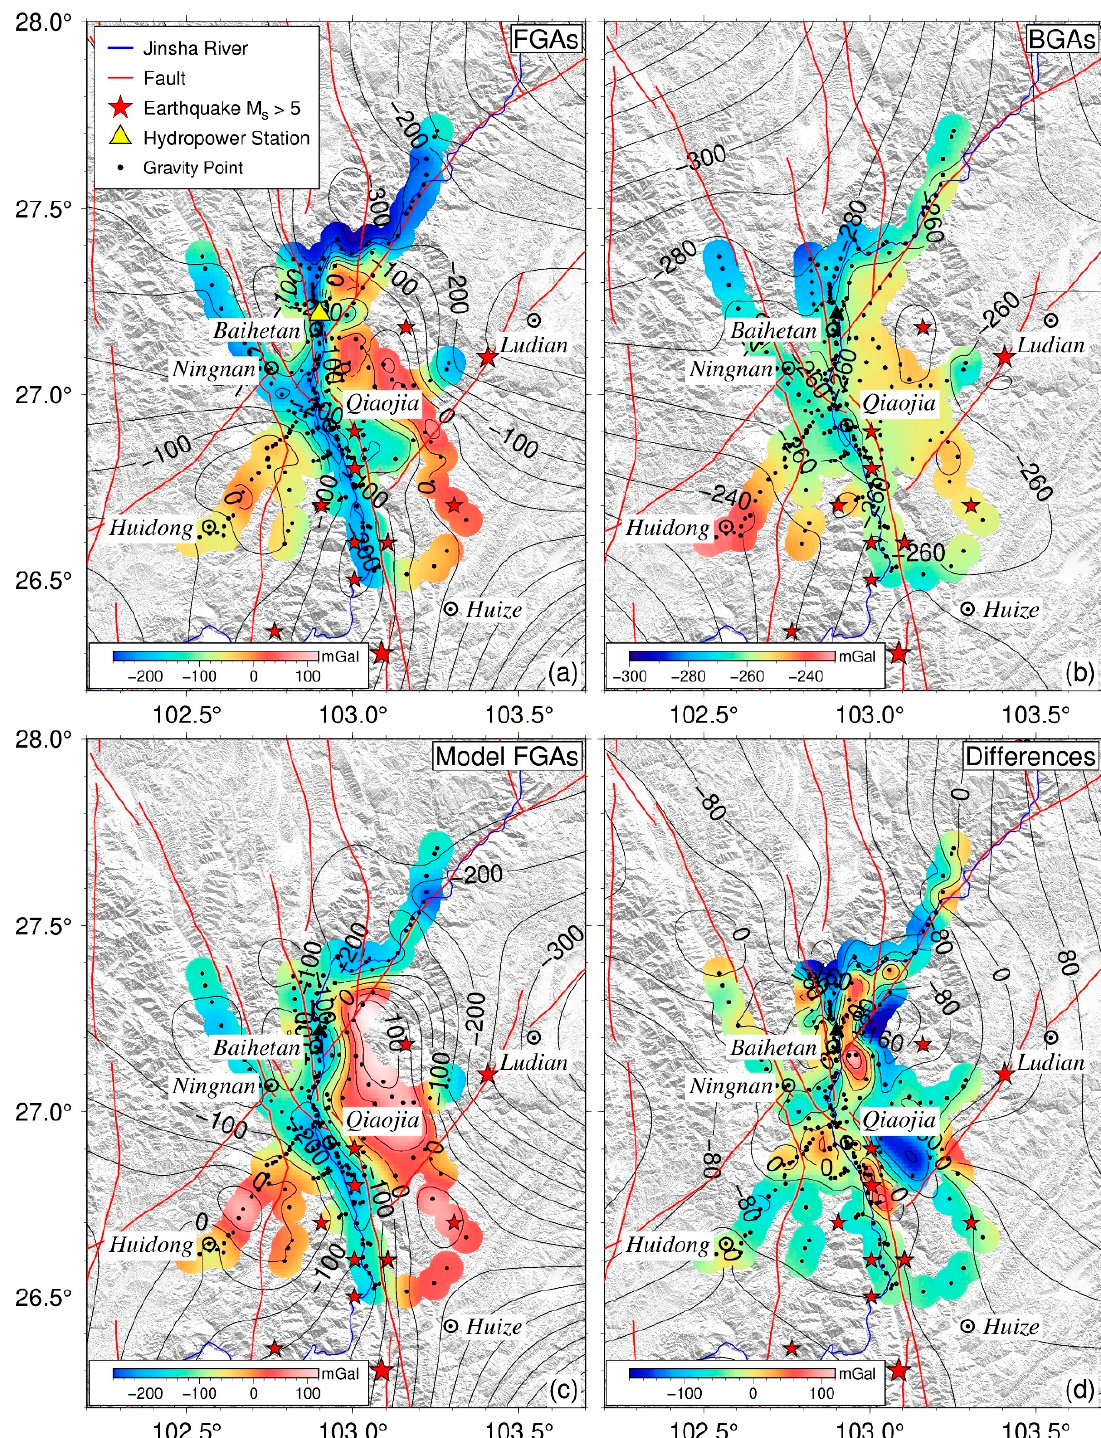
Figure 2. Free-air and Bouguer gravity anomalies around Baihetan reservoir. ( a ) Observed Free-air gravity anomaly; ( b ) Observed Bouguer gravity anomaly; ( c ) Modeled Free-air gravity anomaly from EIGEN-6C4 model [23]; ( d ) differences between the observed and modeled free-air gravity anomalies ( a – c ). The results far from the observation stations (>5 km) have lower accuracy and are presented in the contours. Abbreviations are the same as those in Figure 1a.